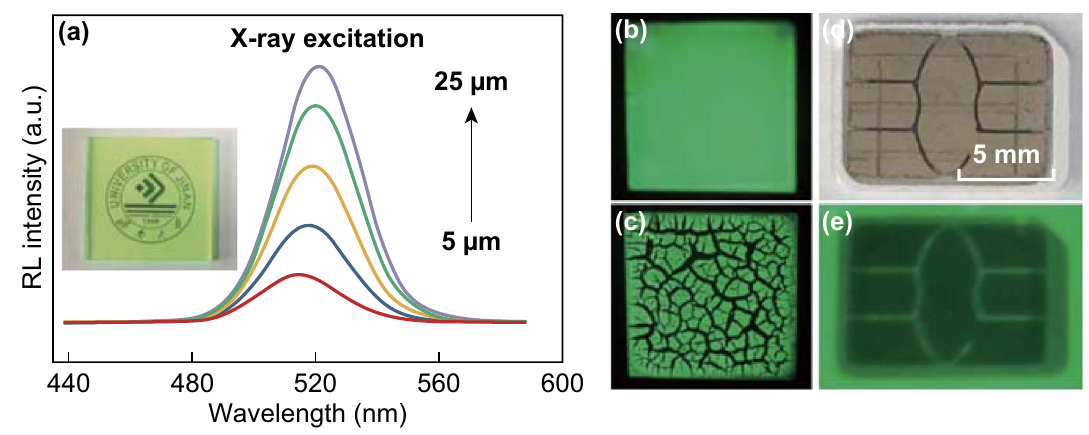
Fig. 5 X-ray scintillation screen based on CsPbBr 3 nanosheets. a Radioluminescence spectra of thin films with varied thickness. The inset shows a semitransparent thin-film sample of a flat surface. Radioluminescent image of b a crack-free screen and c a cracked screen. d Photo- graph and e X-ray image of a SIM